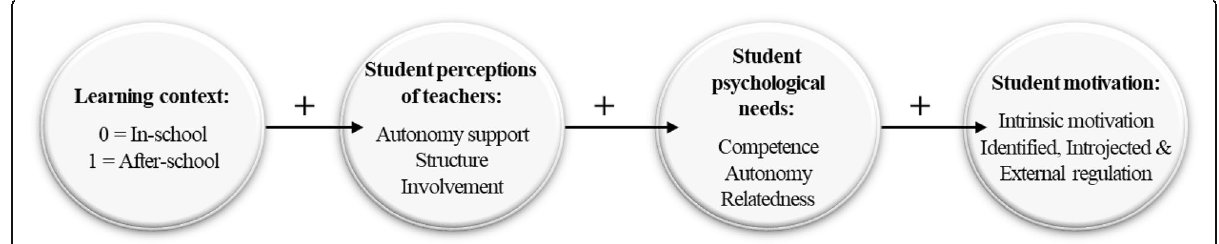
Fig. 1 Conceptual model of the associations between learning context, student perceptions of teachers, student psychological needs, and student motivation based in self-determination